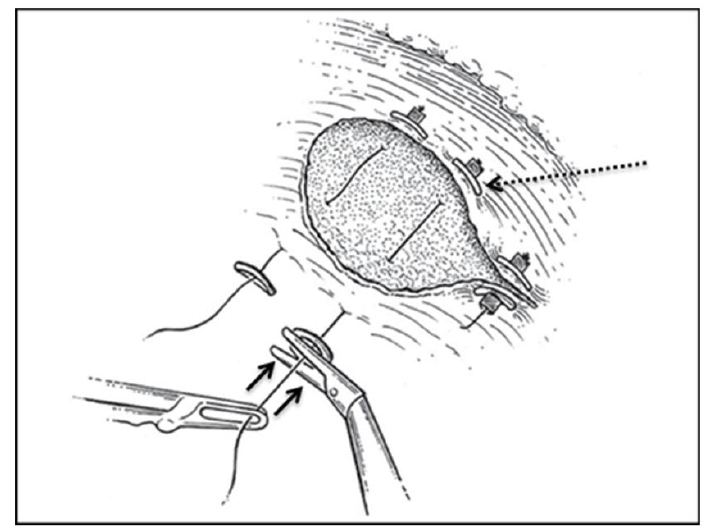
Figure 2. Sliding clip renorrhaphy. Solid lines indicate the direction of force applied to slide clips into position. Dashed line indicates the Hem-o-Lok clip that was placed extracorporeally on the end of the